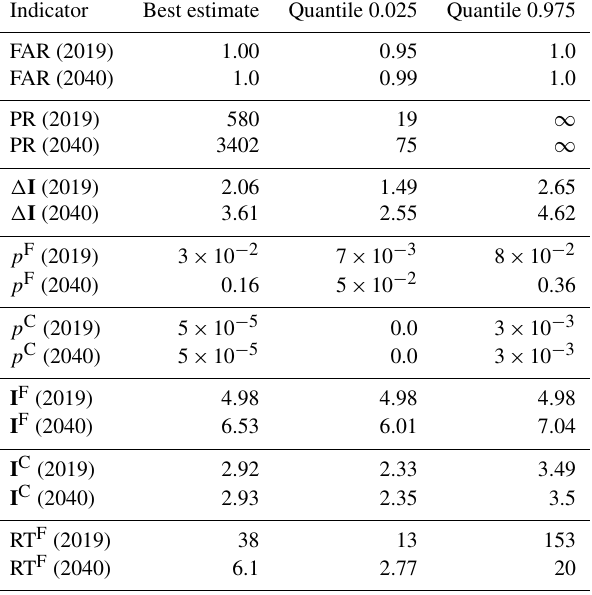
Table 2. Statistics of multimodel synthesis after Bayesian con- straint in the years 2019 and 2040. The first column shows the statis- tics, the second the best estimate, the third the quantile 0 . 025 and the last the quantile 0 . 975.